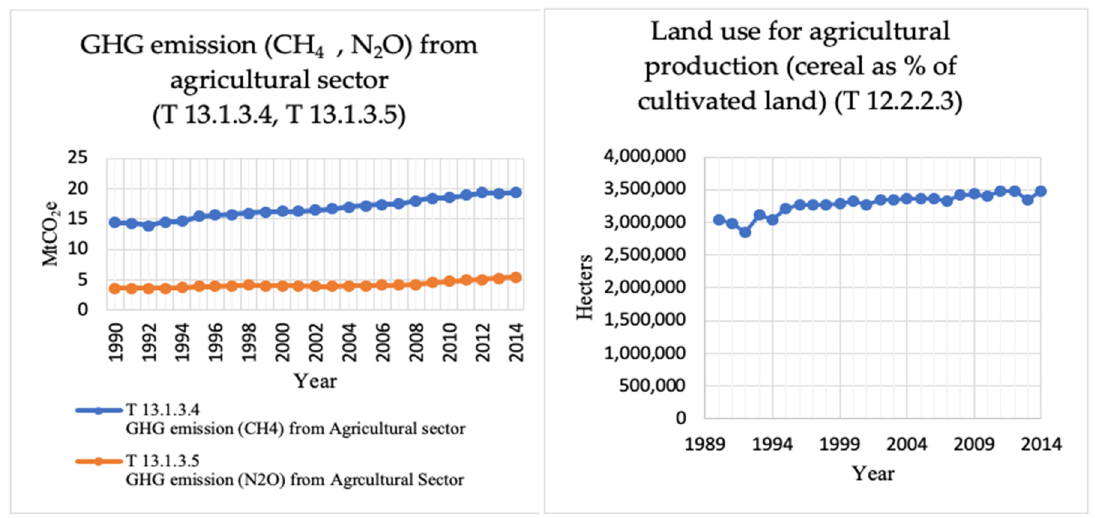
Figure 15. GHG emission (CH 4 , N 2 O) from agriculture sector ( left ) and land use for agricultural production (cereal as of % of cultivated land) ( right ).